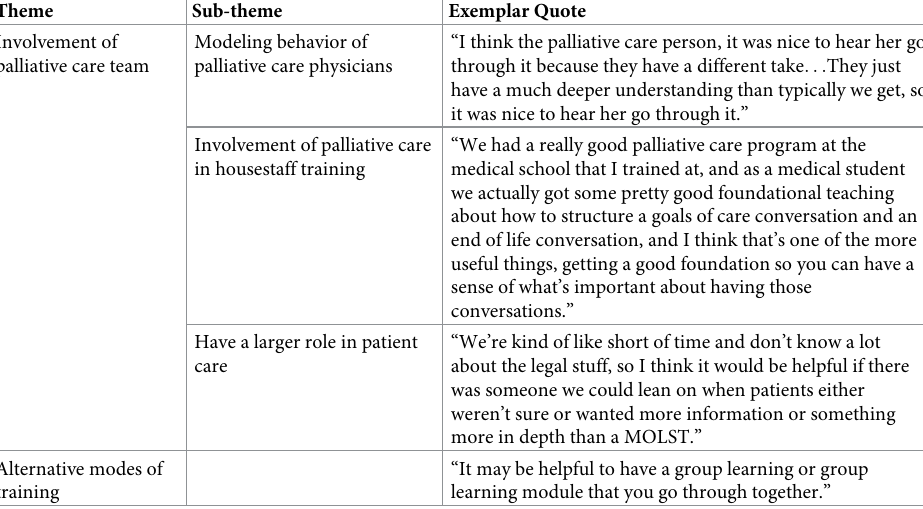
Table 5. Adaptations for improvement of MOLST